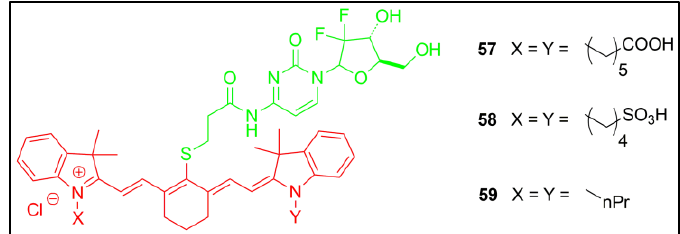
Figure 55. Structure of compounds 57-59 [163].